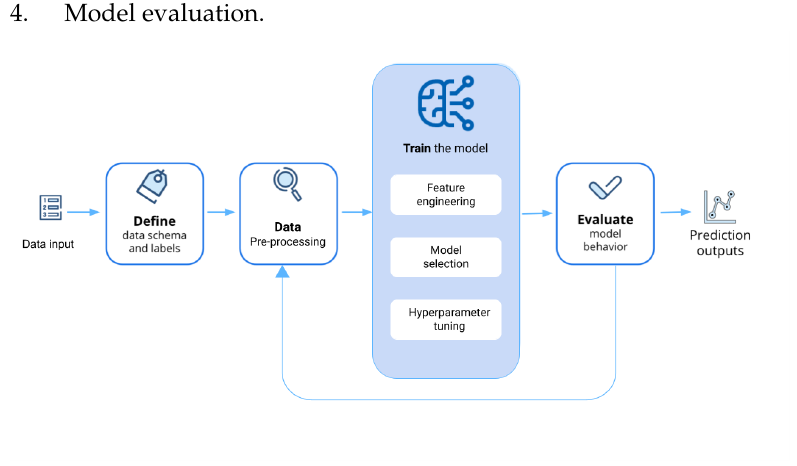
Figure 1. A typical workflow for a machine learning